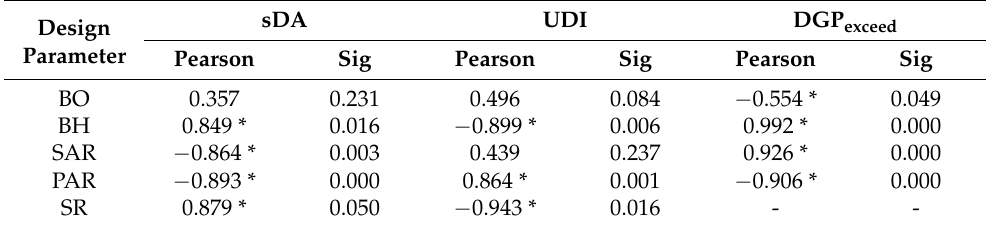
Table 3. Correlation analysis of design parameters and lighting evaluation index.